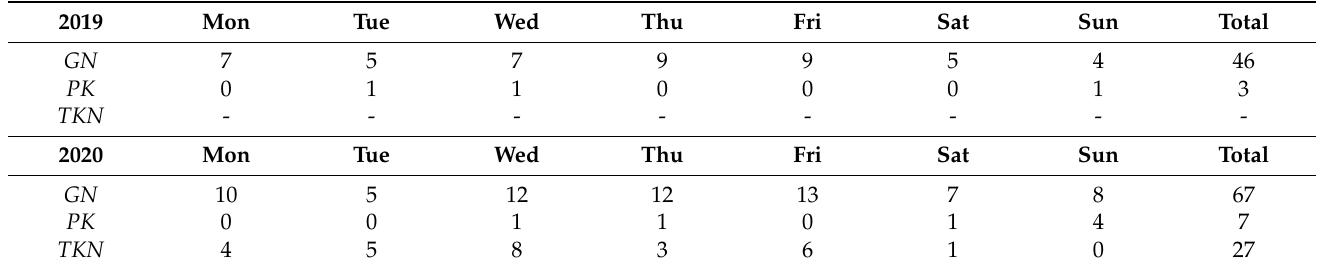
Table 4. The number of posts on the Instagram profiles of the selected Catholic weeklies by day of the week (2019–2020).